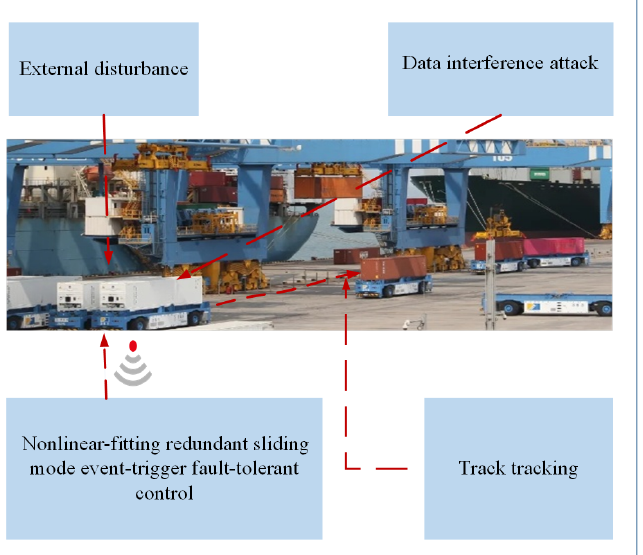
Figure 1. Artificial intelligence transportation robots: operational diagram of the Qingdao Port Freight